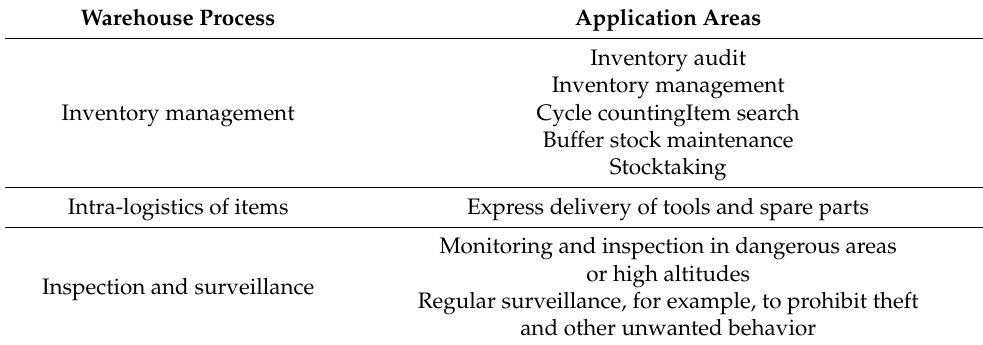
Table 1. Areas of application of drones in warehouses (own study based on